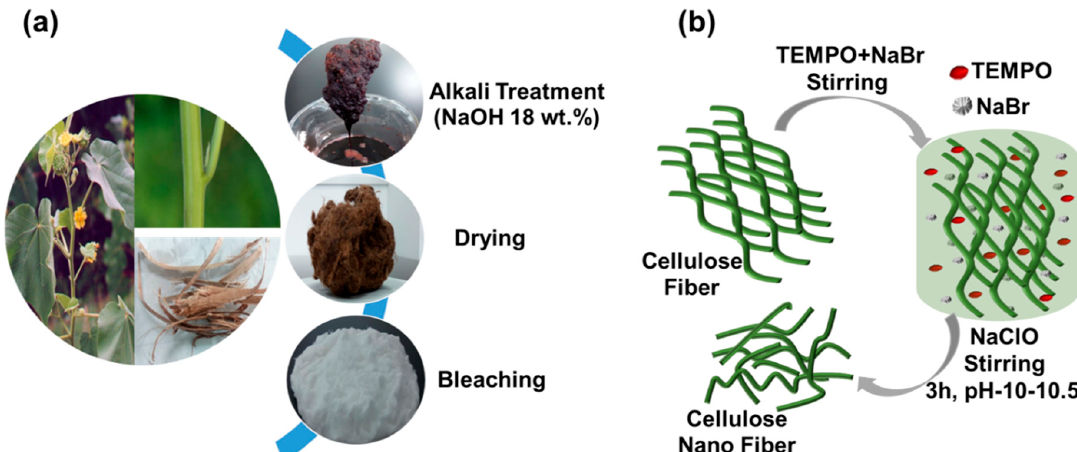
Figure 1. ( a ) Extraction cellulose fibers from the bark of Abutilon theophrasti and ( b ) preparation